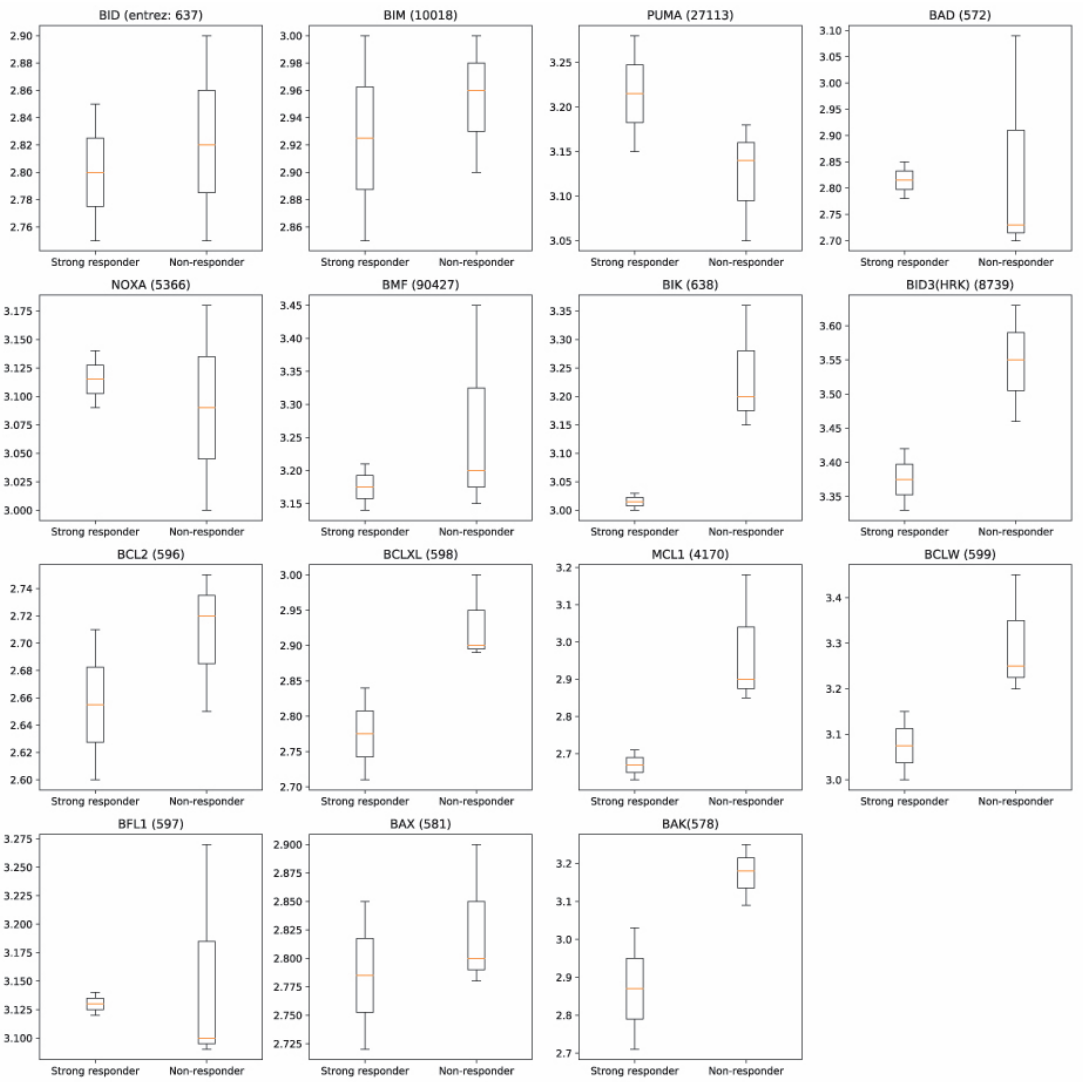
Figure 4. In the functional protein-protein interaction network, Bcl-2 family genes are closer to differentially expressed genes of imatinib-treated patients with strong improvement in forced expiratory volume in 1 s (FEV 1 ) than to non-responders. Whisker plots represent the distance of the genes from each other. Genes in close proximity within protein-protein interaction networks have been found to demonstrate similar biological functions.